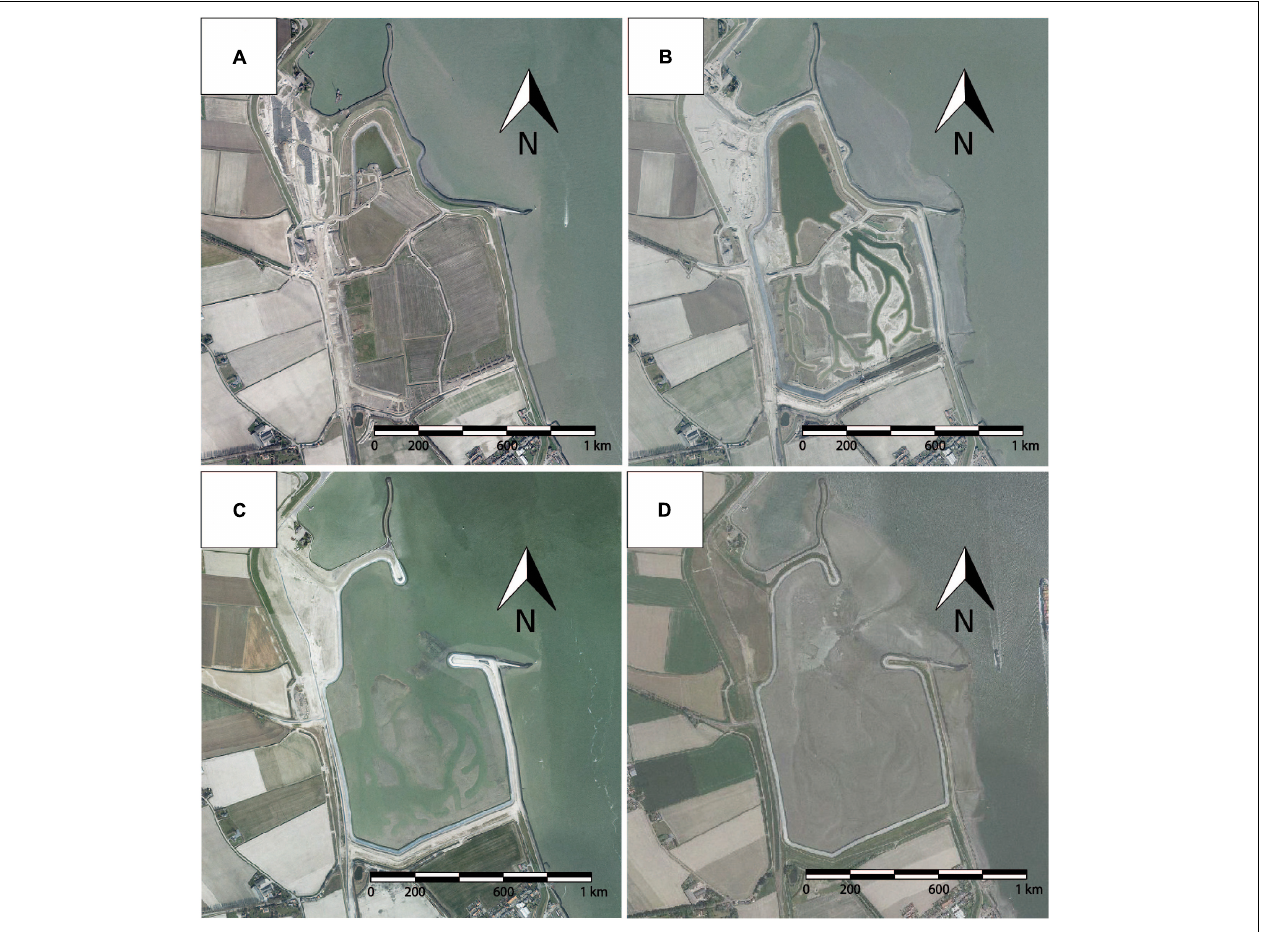
FIGURE 2 | Orthophotos at 1:15000 scale of the Perkpolder basin from the maps of the province of Zeeland; (A) before works in March 2014, (B) shortly before the opening of the inlet in March 2015, (C) in March 2016 and (D) in June